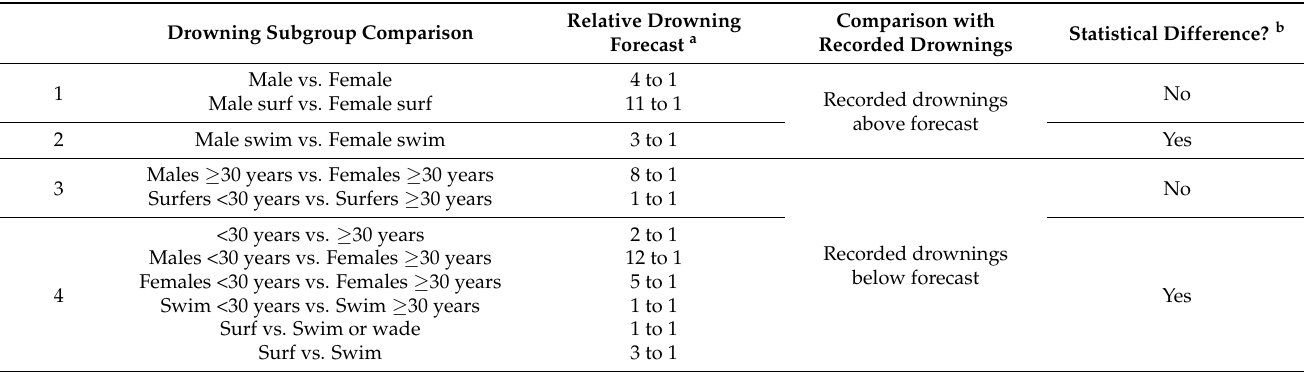
Table 5. Summary results for comparison between derived drowning ratio and specific drowning rate for subgroups within risk marker